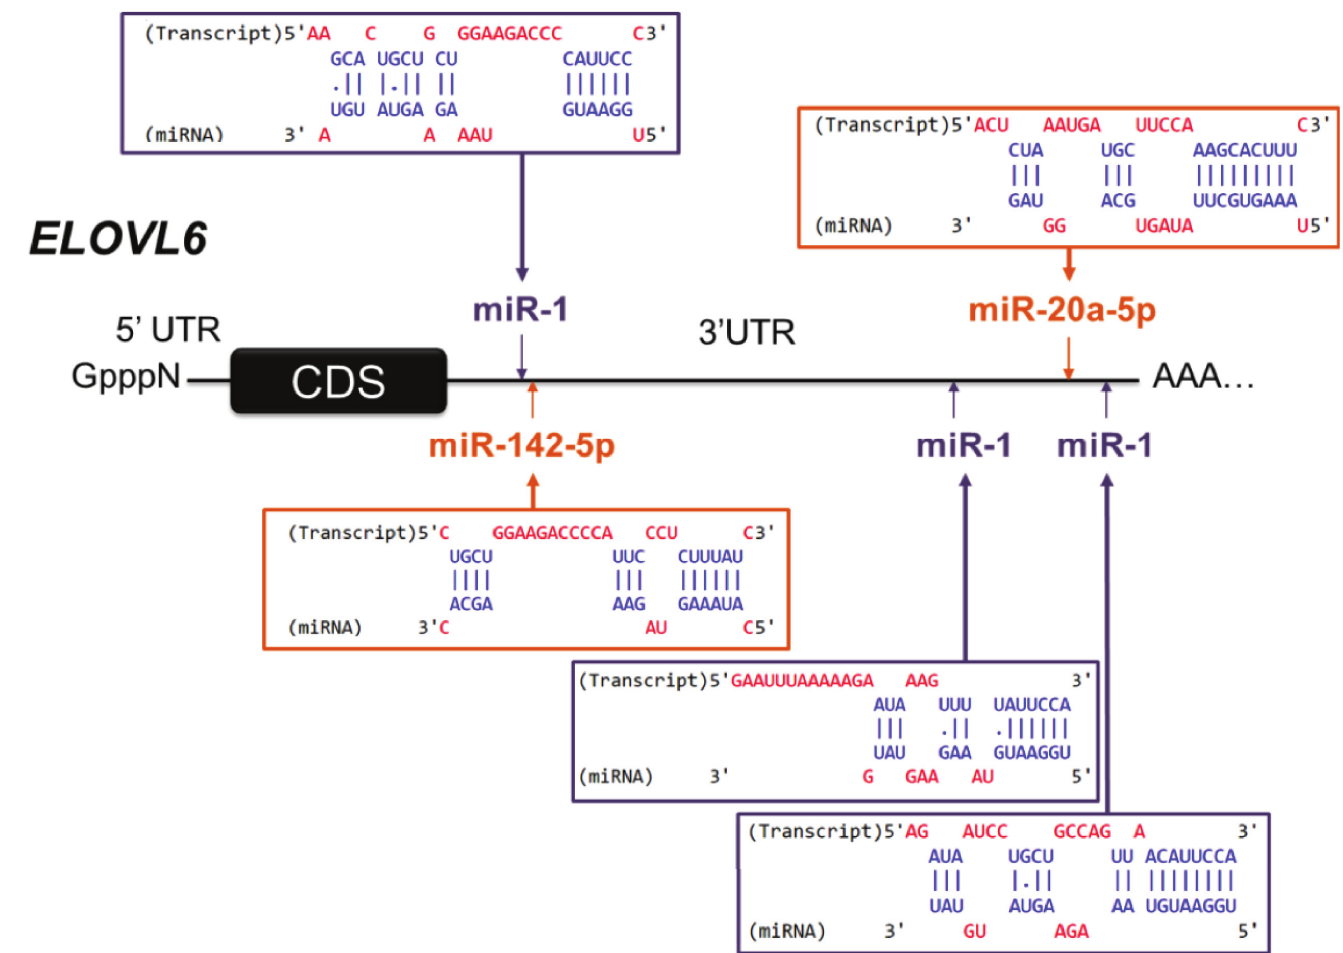
Fig 4. Predicted binding site of miR-20a-5p , miR-142-5p and miR-1-3p in the 3’UTR of ELOVL6 . Bindingsites were predicted with Diana microT-CDS (http://diana.imis.athena-innovation.gr/DianaTools/index.php?r=microT_CDS/).